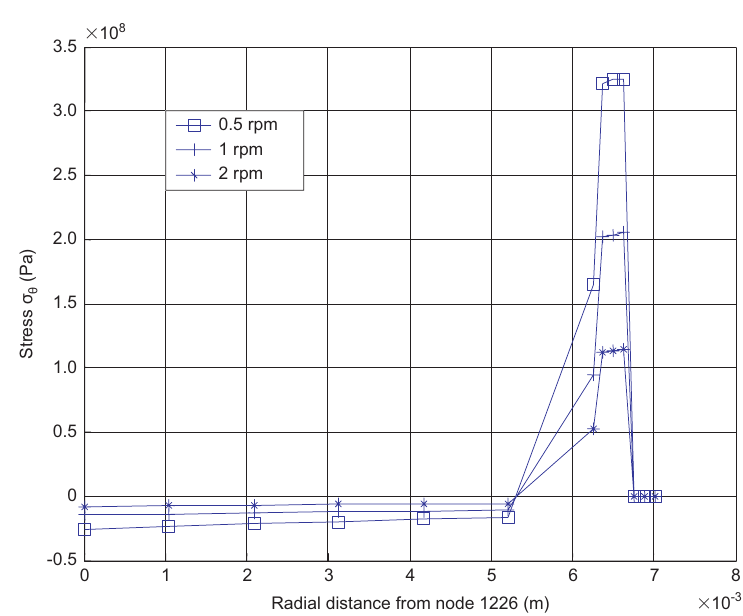
Figure 17 Hoop stresses along radial direction at angle 103.5 ° from node 1226 to node 94 when moving heater is over the spot for different speeds at the fourth rotation.